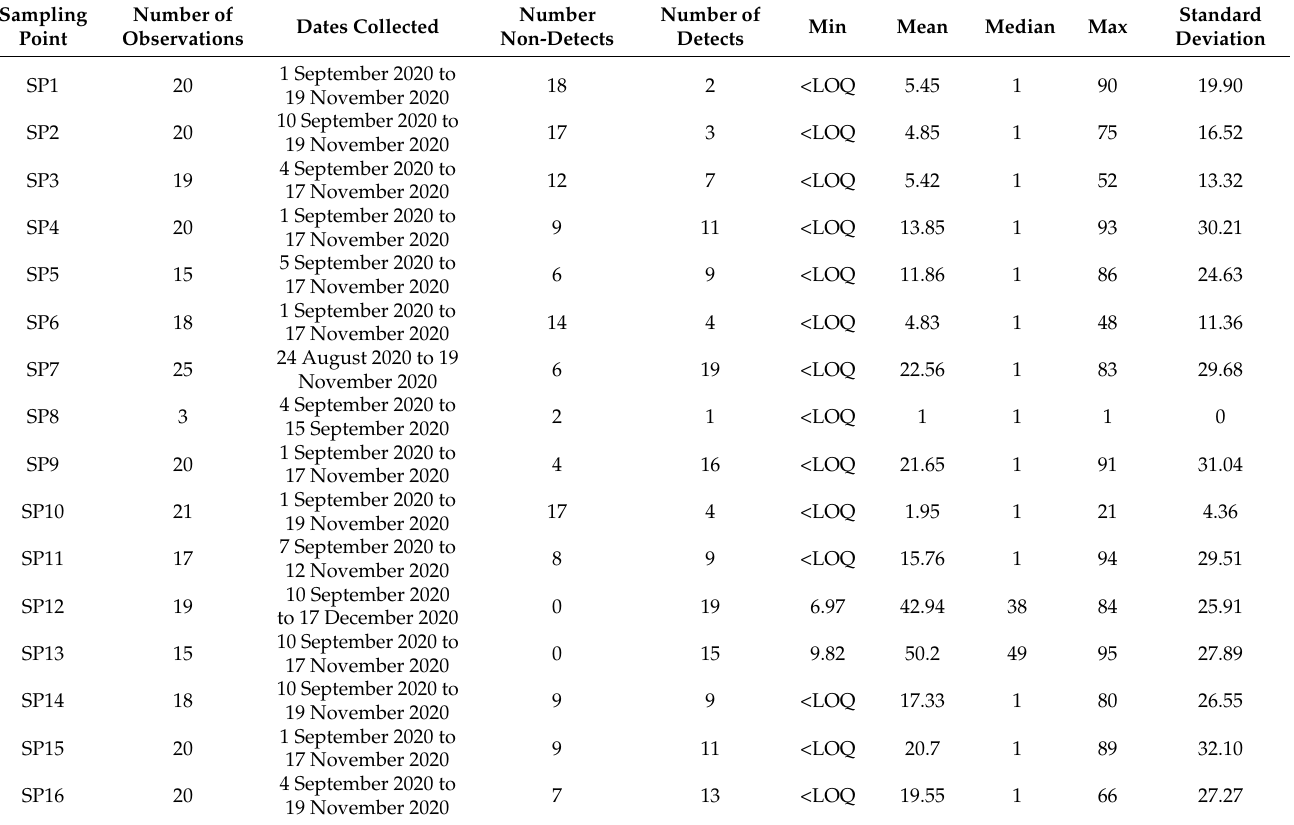
Table 1. Wastewater sample data for each sampling point